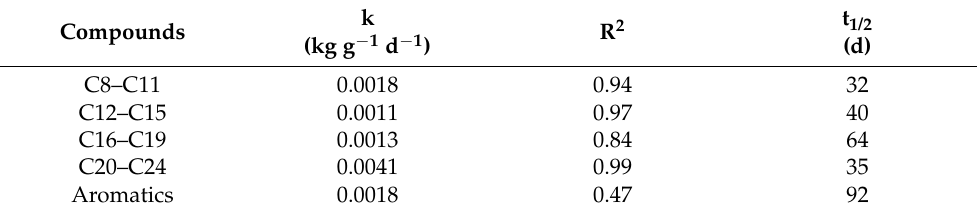
Table 5. Second-order reaction rate constants and half-life times.